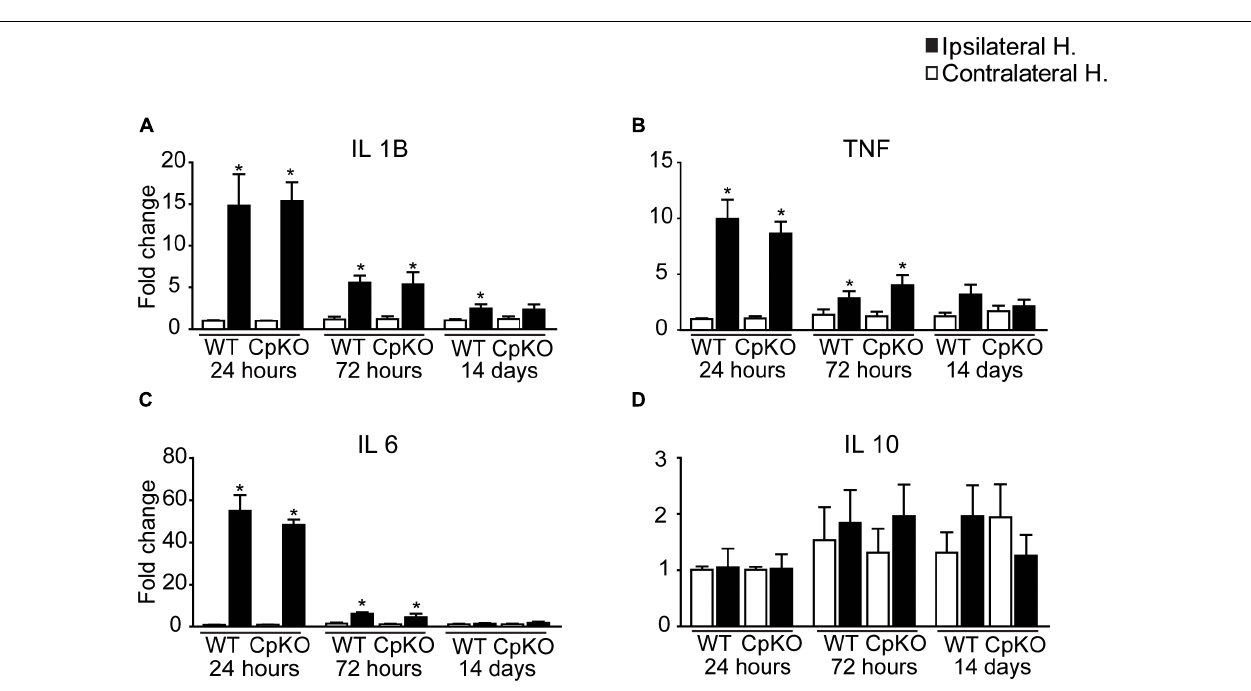
FIGURE 9 | Changes in expression of inflammatory cytokines after pMCAO. The change in the mRNA expression of four key inflammatory cytokines in the brain were assessed by qPCR at 24, 72 h and 14 days after pMCAO in wildtype and CpKO mice. Data are plotted as fold-change on the ipsilateral ischemic side as compared to the uninjured contralateral side. Note the marked increases in IL-1 β (A) , TNF (B) and IL-6 (C) at 24 h in both genotypes. They remained elevated at lower levels at 72 h. There were no significant changes in expression of IL-10 (D) . ∗ p -value ≤